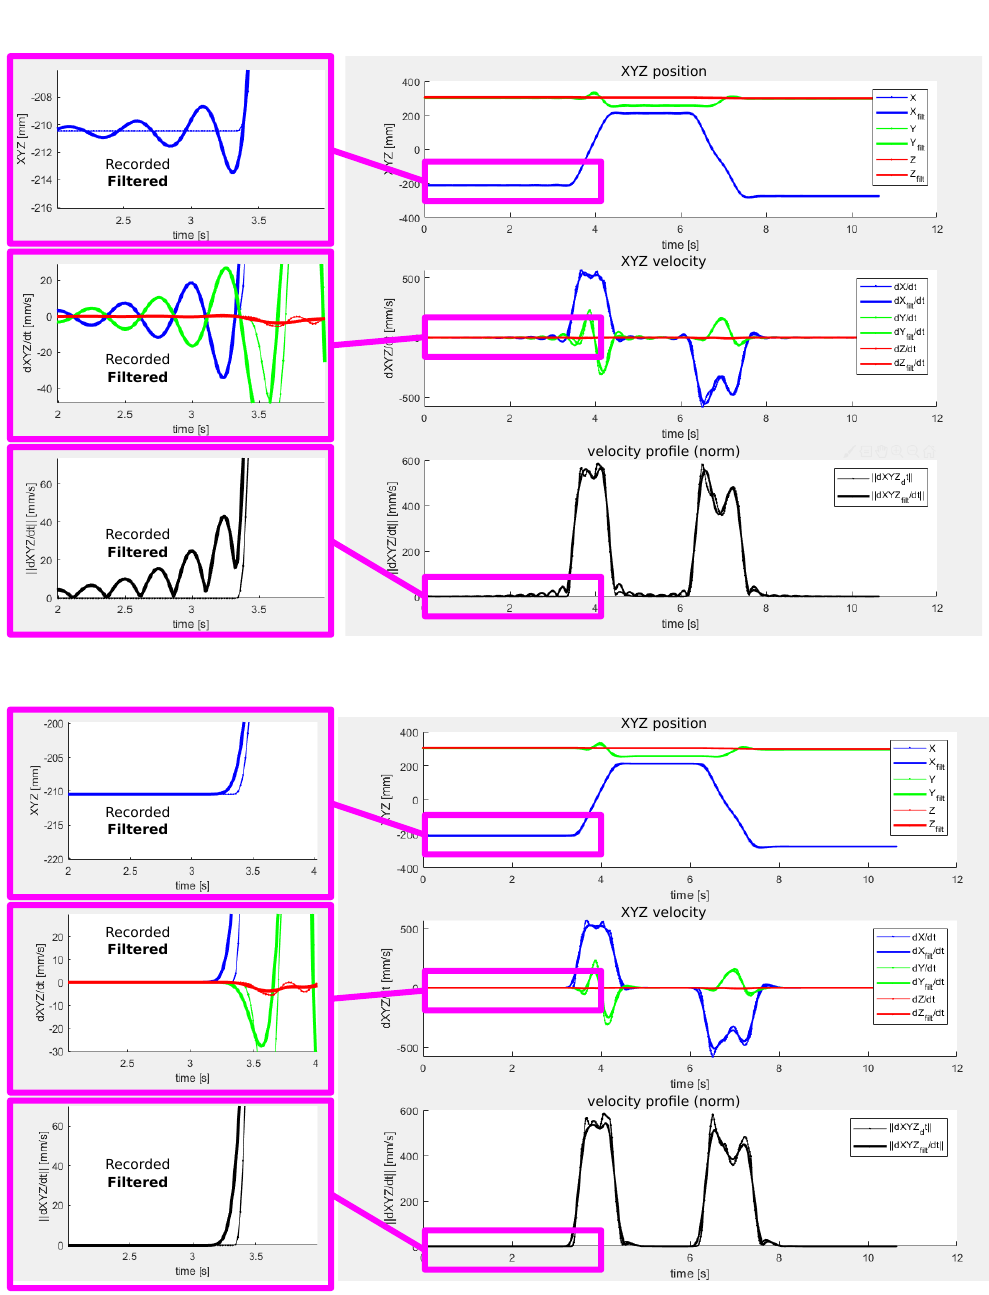
Figure 12. Smoothing filter induced oscillations during rapid steady-state to motion transitions— ( top ) forward-backward filtering using 6th order Butterworth filter, ( bottom ): zero-phase FIR filter with monotonous step response designed by windowing